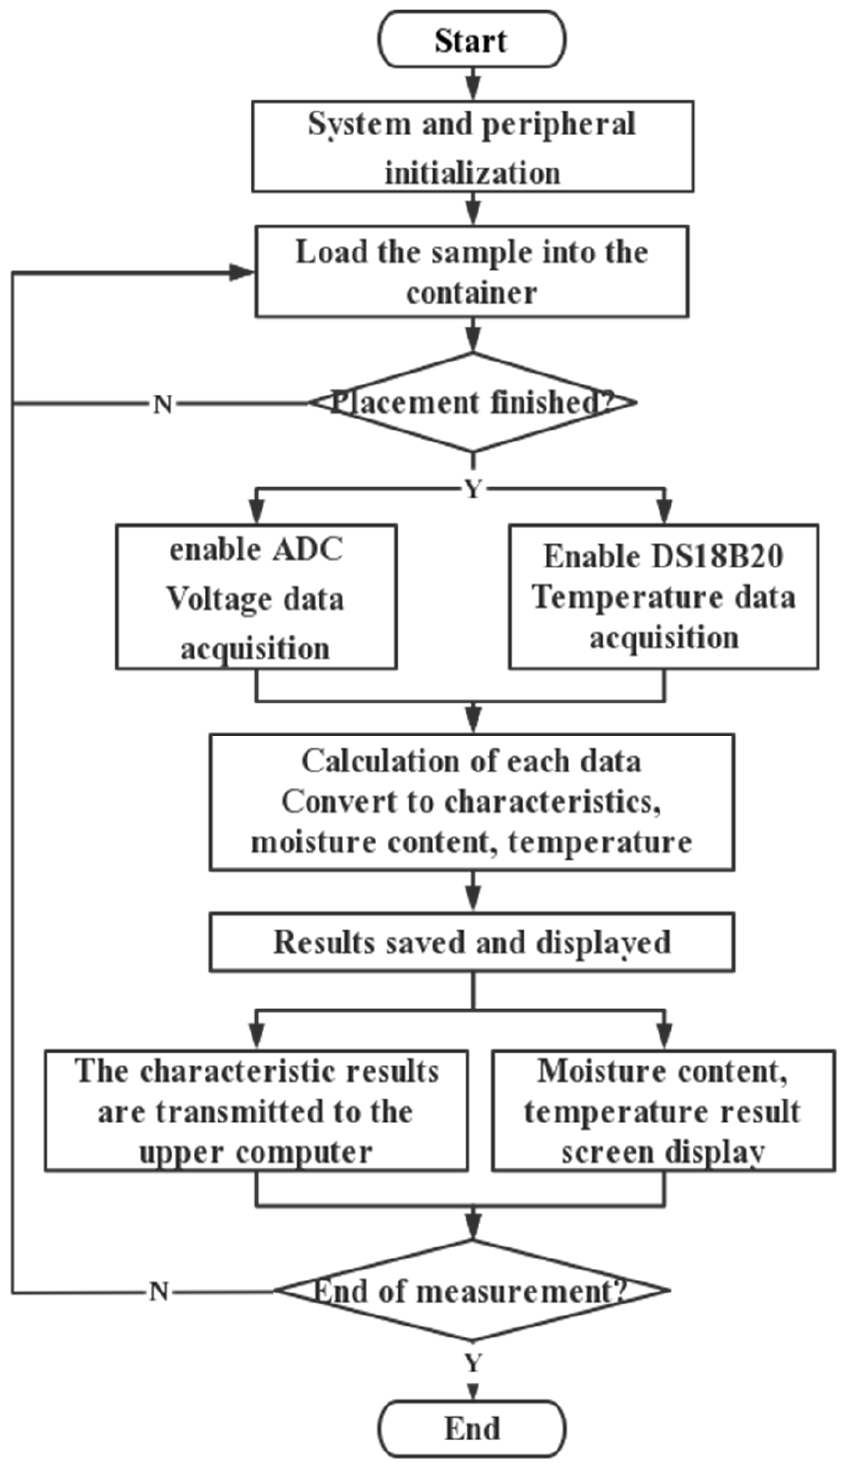
Figure 6. Program flow chart.